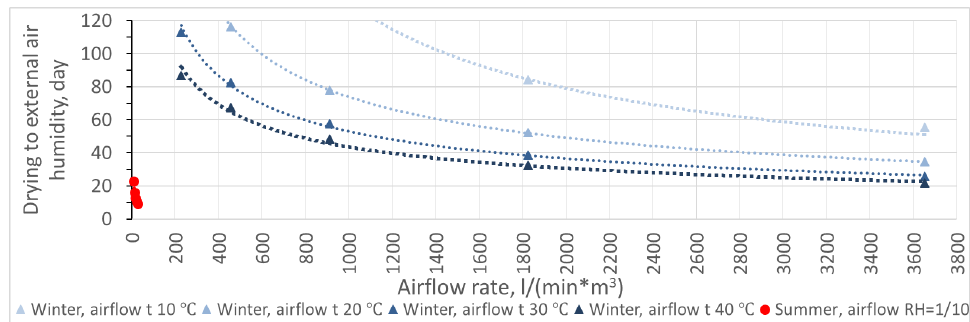
Figure 7. Moisture dry-out duration at stable temperature conditions to outside air humidity (pore air vapour content in summer 9.3/10 = 0.93 (g/m 3 ) and in winter 3.3 (g/m 3 ). Blue lines indicate drying in winter at different air inflow temperatures, red line shows drying in summer with reduced moisture content in the air.